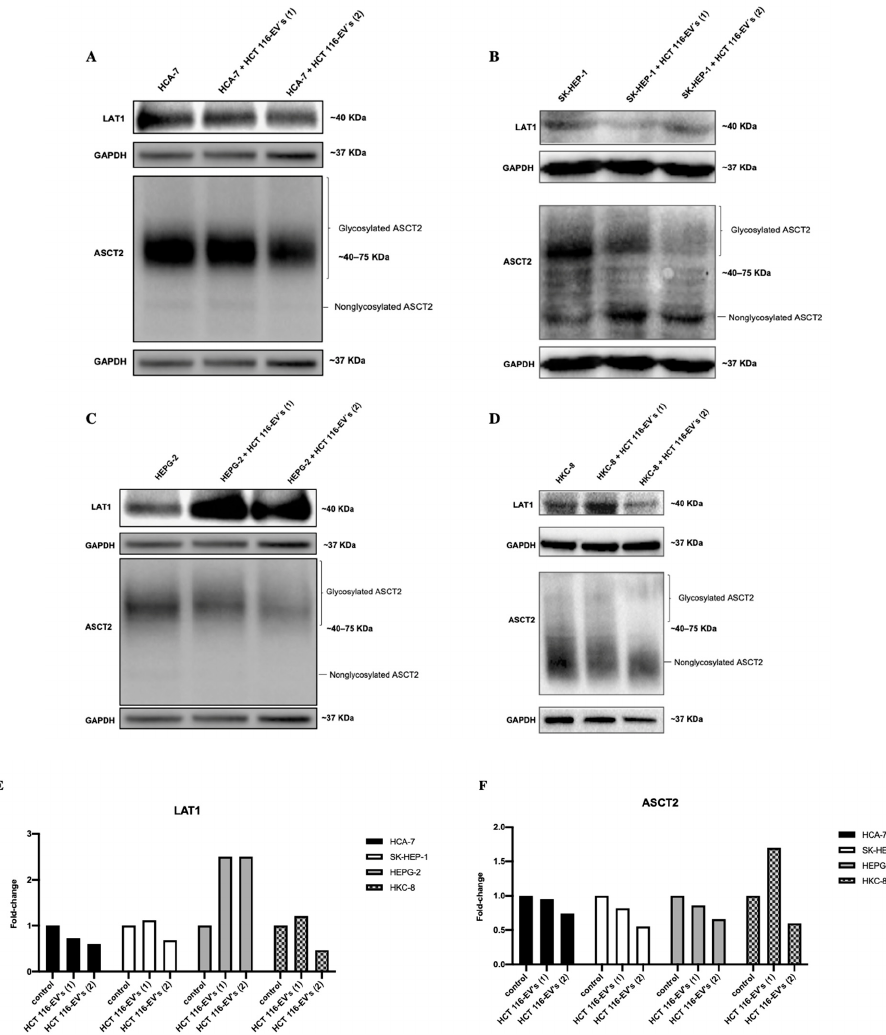
Figure 6. The experience was replicated two times for each sample. LAT1 and ASCT2 protein levels and HCT 116-EVs’ uptake effects in ( A ) HCA-7, ( B ) SK-HEP-1, ( C ) HEPG-2 and in ( D ) HKC-8 cell